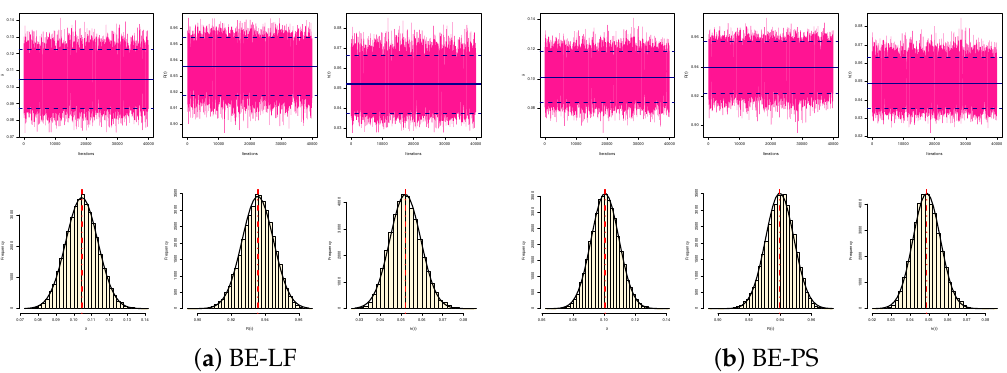
Figure 7. Trace ( top ) and histograms ( bottom ) plots of δ , R ( t ) and h ( t ) from mechanical equip- ment data.